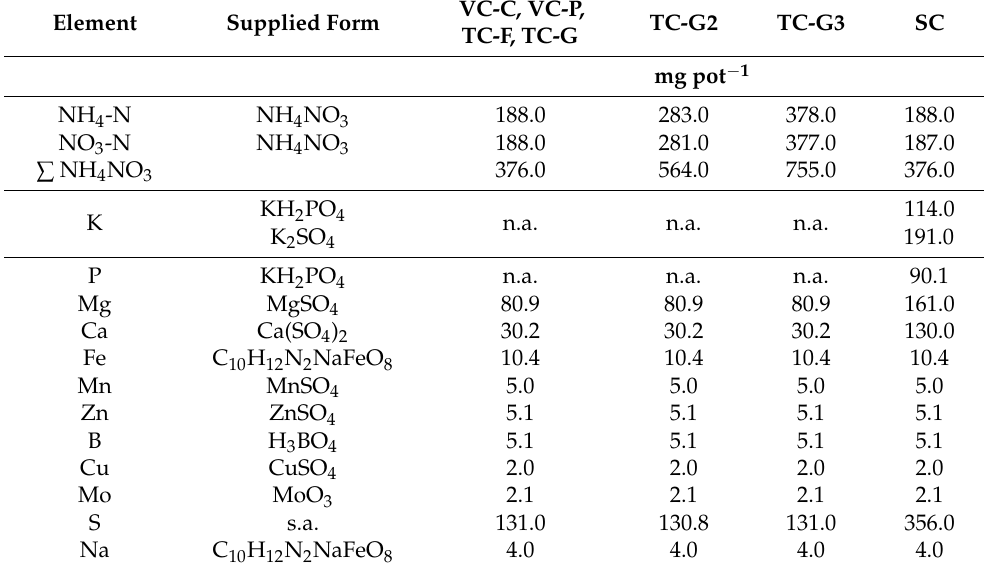
Table 1. Total quantities of nutrient salts applied to each pot via a solution, split into three doses, supplied on days 1, 2, and 21 of the growth period. SC, sand control; TC-F, thermophilic compost from fecal matter; TC-G, thermophilic compost from green waste; TC-G2 and TC-G3, thermophilic compost from green waste with additional N fertilization; VC-C, vermicompost with coir bedding material; VC-P, vermicompost with paperboard bedding material. S was supplied through a range of salts, noted as s.a. = see above. P and K were solely supplied by the composts and only added to the SC treatment, noted as n.a. = not